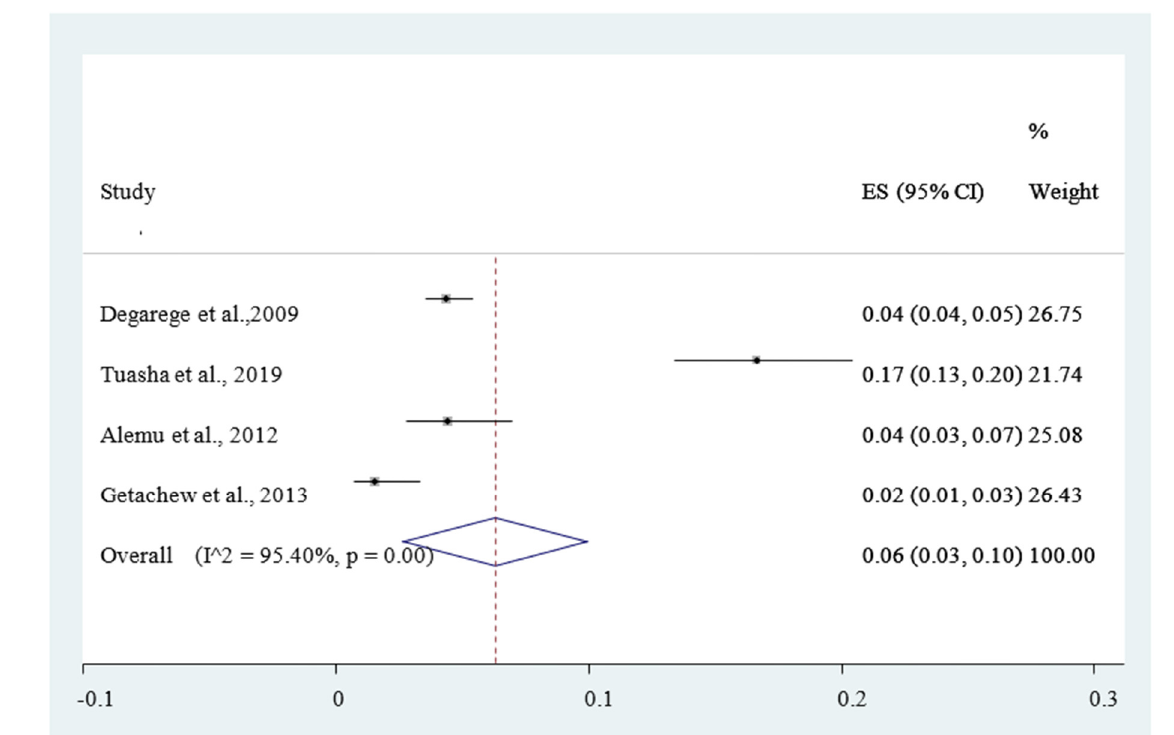
Figure 5. Forest plot of 4 studies on magnitude of Plasmodium vivax infection among out patients in Ethiopia, 2020.